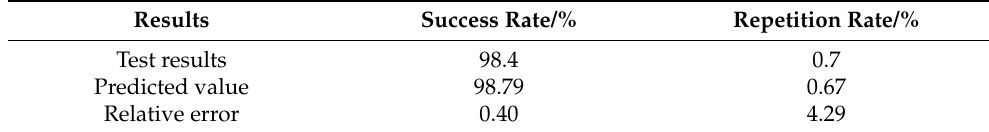
Table 4. Results of validation experiments.